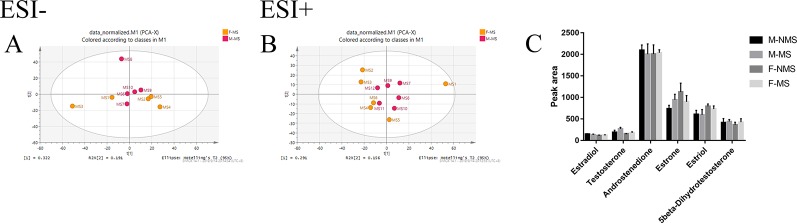
MS shows no gender difference in depression-like behavior in male and female rats. (A) PCA score plot of the F-MS and M-MS groups in negative ion mode. (B) PCA score plot of F-MS and M-MS groups in positive-ion mode. (C) Peak area of sex hormones and their metabolites detected by LC–MS/MS.